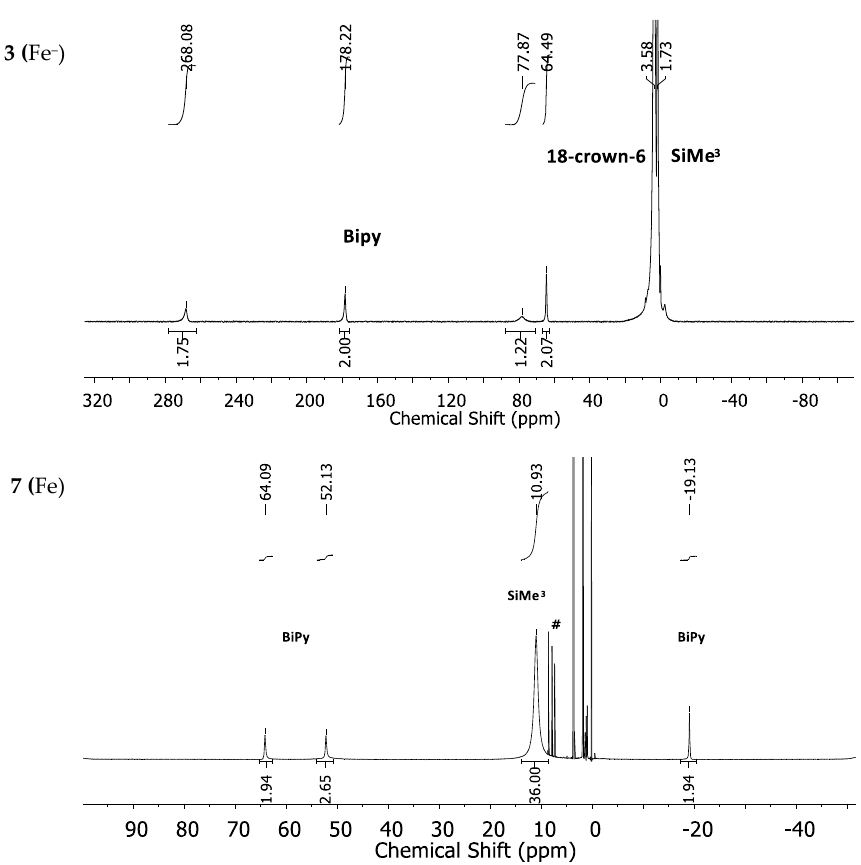
Figure 3. 1 H-NMR spectra of the iron complexes 3 (Fe − ) (top) and 7 (Fe) (bottom) in THF-d 8 . # denotes free 2, 2′ -bipyridine as an impurity.